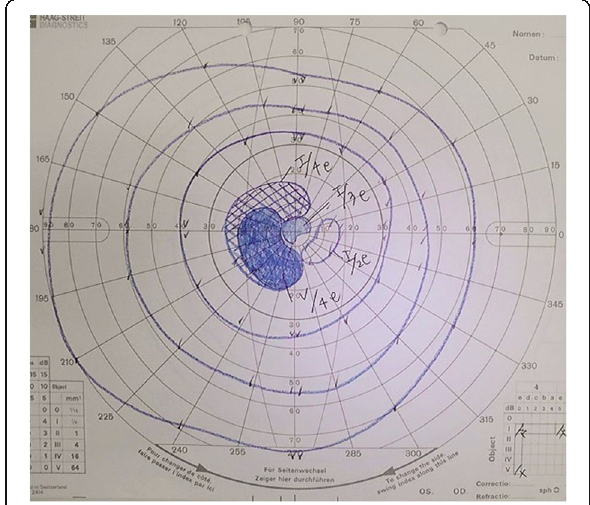
Fig. 2 The Goldman perimeter indicated paracentral visual field defects in her left